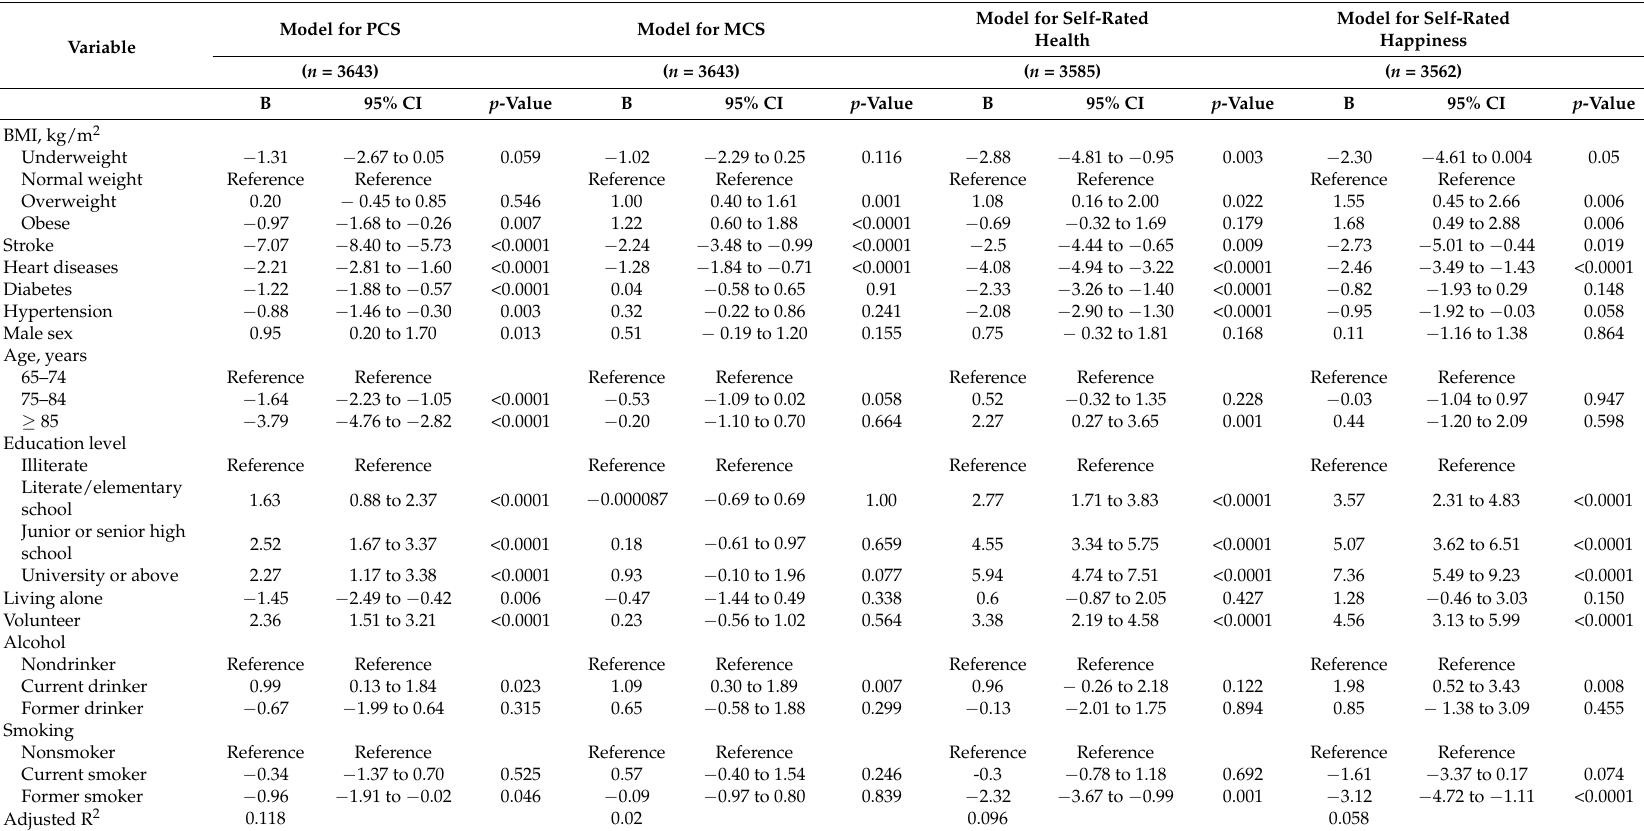
Model for Self-Rated